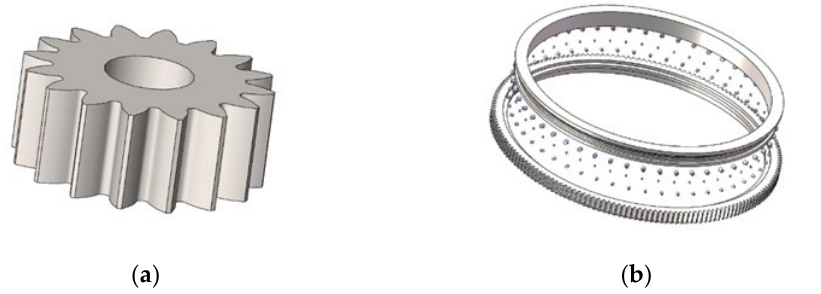
Figure 1. ( a ) Drive pinion model; ( b ) slewing bearing model.